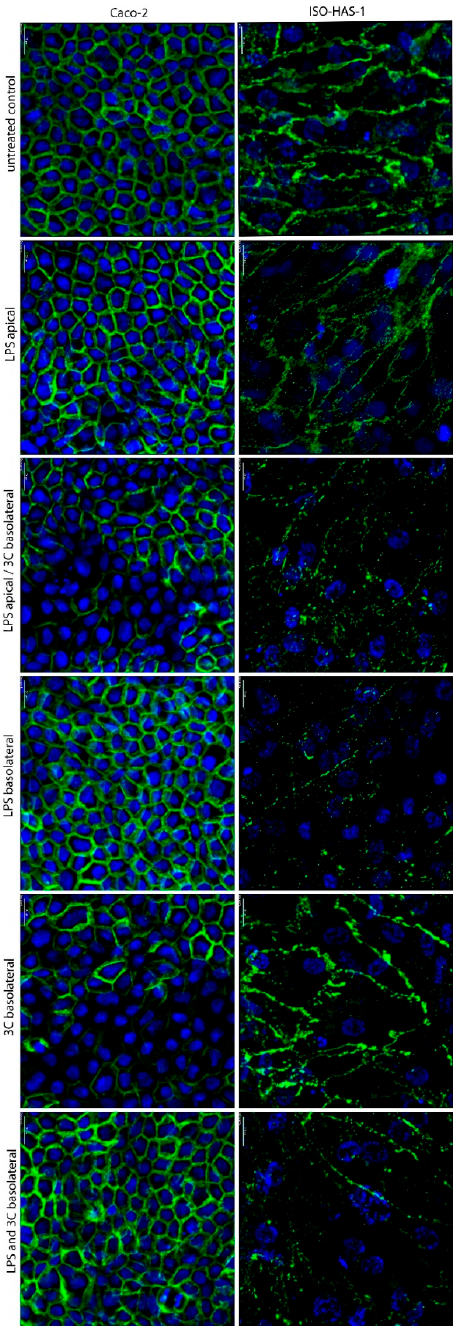
Figure 1. Immunofluorescence staining of the coculture CC (Caco-2 / ISO-HAS-1) after stimulation with di ff erent pro-inflammatory mediators for 48 h. apical: stimulation in the upper well (Caco-2), basolateral: stimulation in the lower well (ISO-HAS-1); LPS: lipopolysaccharide (1 µ g / mL); 3C: cytokine mixture ((IL-1 β (100 U / mL), TNF- α (600 U / mL) and IFN- γ (200 U / mL)); green signal: immunofluorescence of β -Catenin for both cell types Caco-2 ( left column) and ISO-HAS-1 ( right column); blue signal: nuclei stained with Hoechst 33342; scale bar: 20 µm.